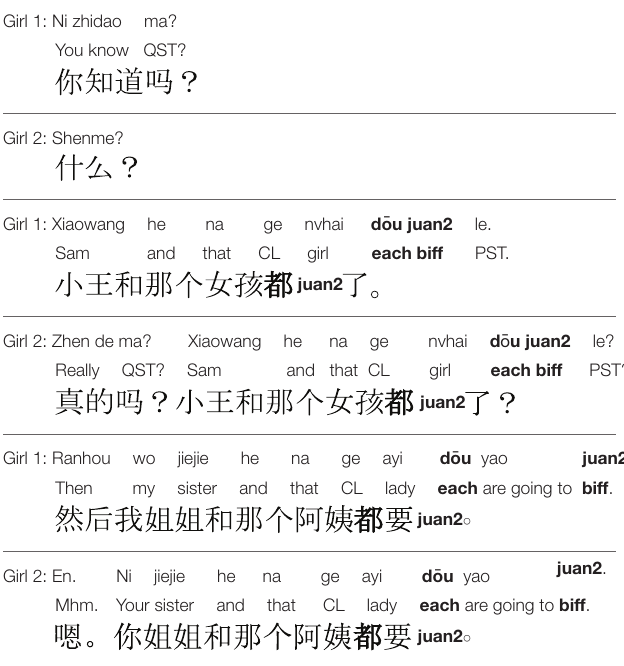
TABLE 6 | Dialogue presented to Mandarin participants during the Familiarization Phase of Experiment 2c. Girl 1: Ni zhidao